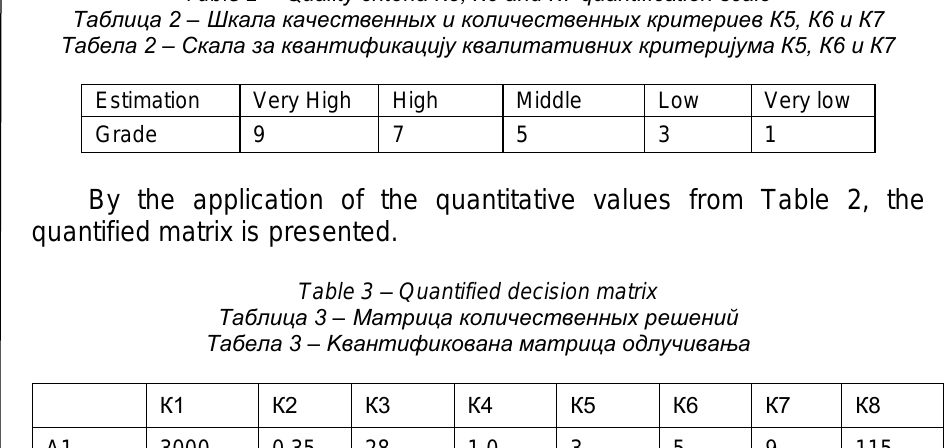
Table 2 – Quality criteria К5, К6 and К7 quantification